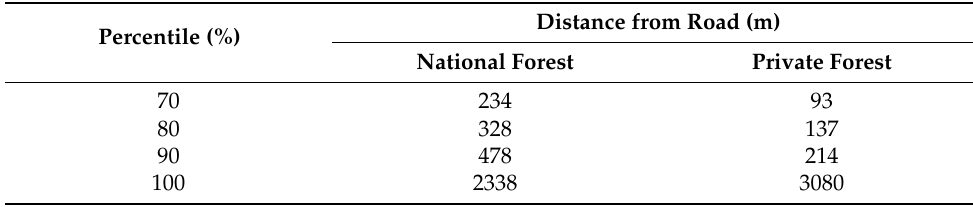
Table 7. Distance of forest management areas from